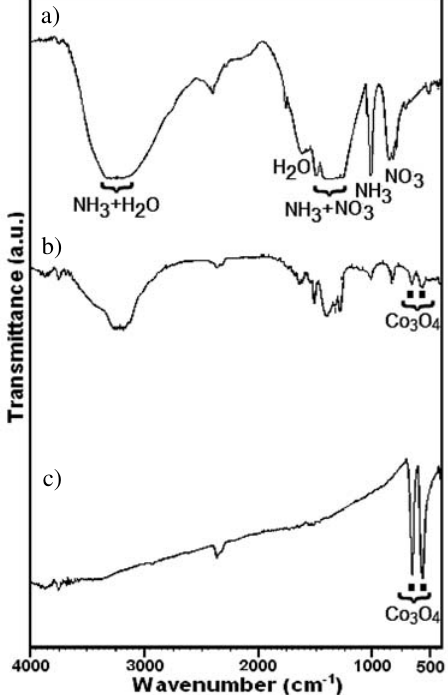
Figure 1. TG and DTA curves of the [ Co(NH plex.